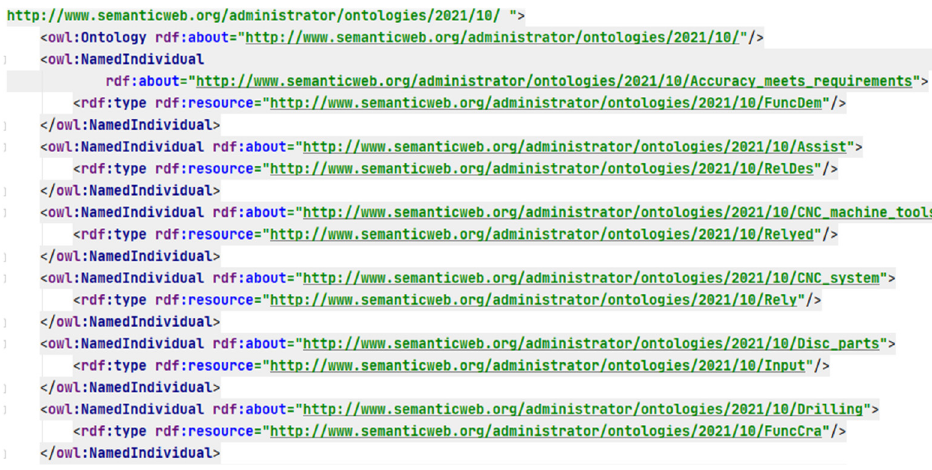
Figure 4. Part of the core code of a certain type of CNC machine tool.